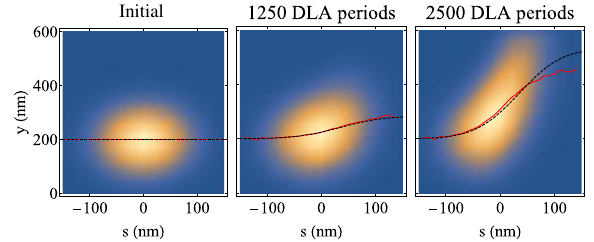
FIG. 8. Initial bunch distribution and bunch distribution after 1250 and 2500 DLA grating periods. The red curves show the means of transverse slices in comparison to the analytical estimates (black curves). Periods